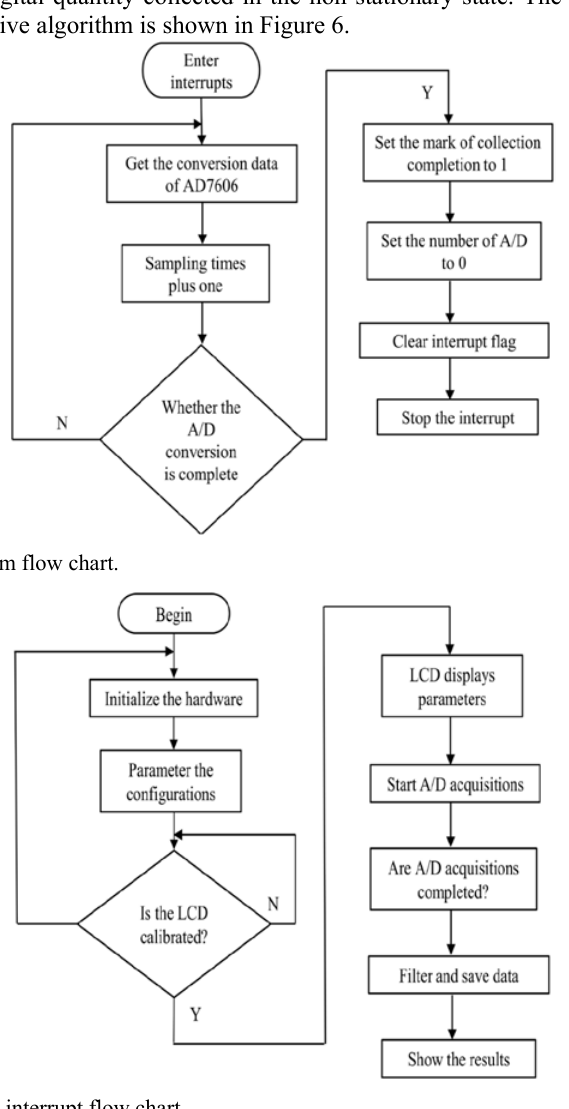
Fig. 5. The external interrupt flow